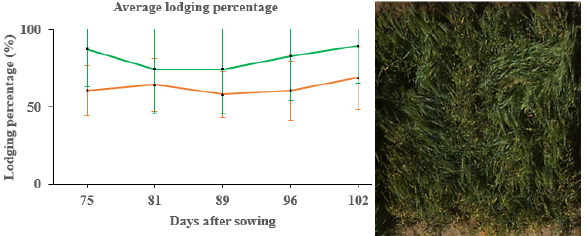
Figure 8. Average lodging percentage (%) with standard deviation for both sowing densities (high = green, low = orange) and genotype 3 (left). RGB image to illustrate the lodging pattern for genotype 3